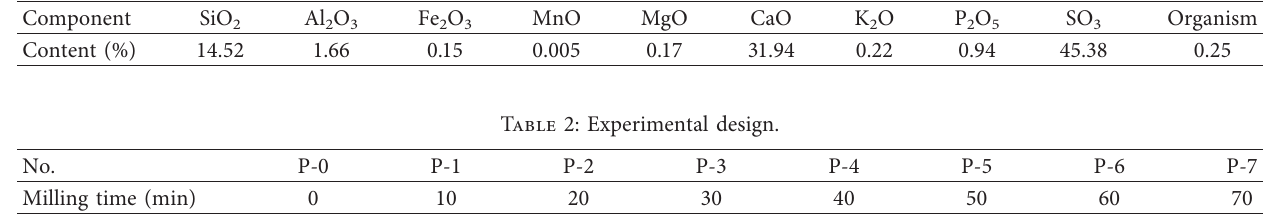
Table 1: Chemical composition of phosphogypsum.